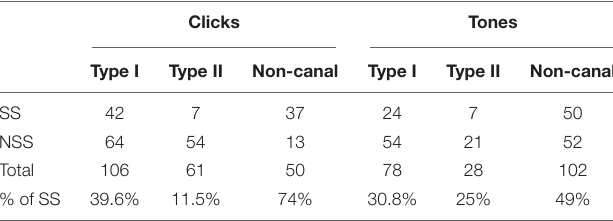
TABLE 1 | Summary of the responses of vestibular nucleus neurons to clicks or tone